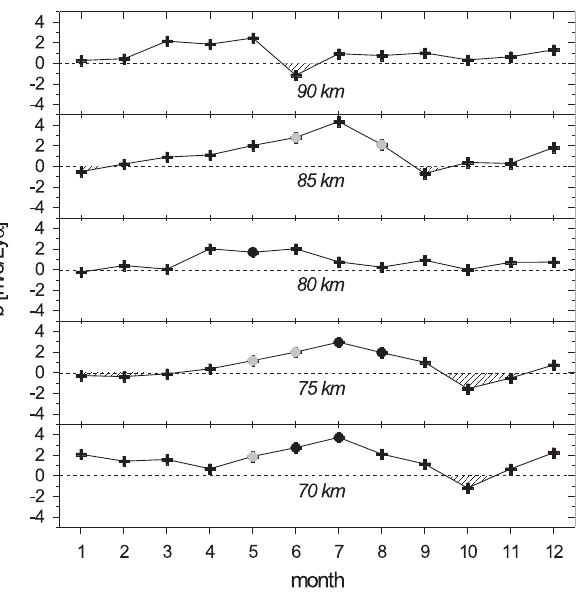
Fig. 8. Seasonal variation of the partial regression coefficient b (see Eq. 1) between the mesospheric meridional wind at Juliusruh and the solar activity for different heights. Significance level χ is marked by black dots ( χ ≥ 95%), grey dots ( χ ≥ 90%), and crosses ( χ< 90%).